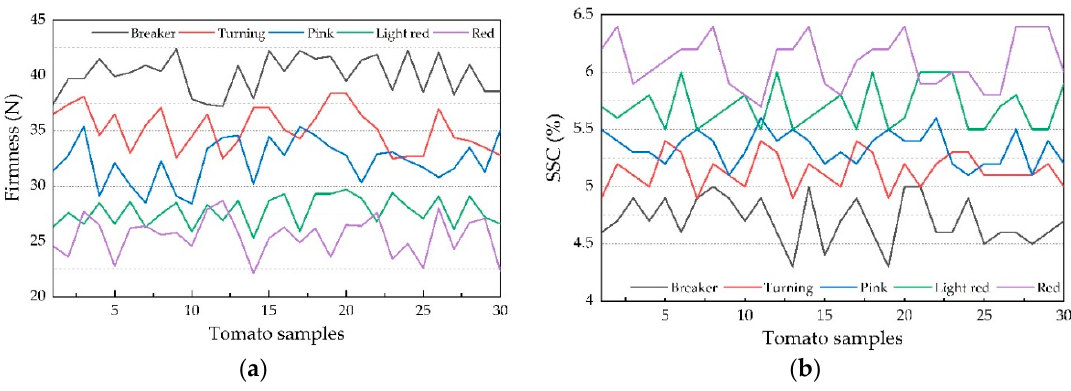
Figure 3. Data distribution of tomato maturity indices at different maturity stage. ( a ) Firmness index. ( b ) SSC index.